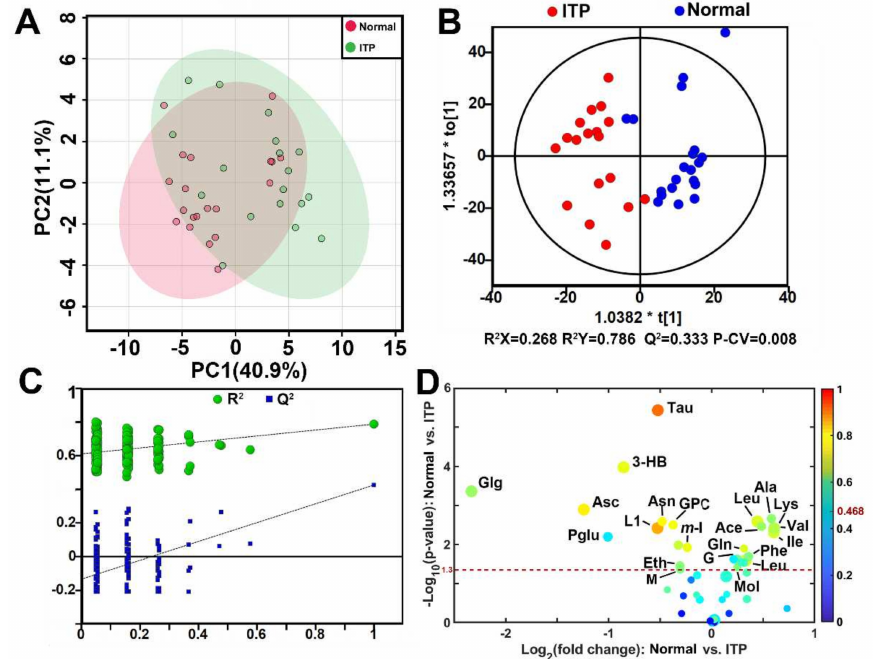
Figure 2. ( A ). The scores plot of principal component analysis (PCA) of 1 H NMR spectral data of spleen derived from the ITP patients and the normal subjects. ( B ). The scores plot of orthogonal partial least squares − discriminant analysis (OPLS − DA) of 1 H NMR spectral data. P − CV: p -value of CV − ANOVA analysis. ( C ). The plot of response permutation test of OPLS − DA model. ( D ). The vol- cano plots of discriminative metabolites between the ITP and the normal subjects. Each dot represents a metabolite. The color of dots represents the absolute value of Pcorr and the size of dot represents the VIP. The dash line represents the cut − off value for p -value of the discriminatory metabolites: 3 − HB: 3 − hydroxybutyric acid, Ace: acetate, Ala: alanine, Asc: ascobate, Asn: asparagine, Eth: ethanol; Gln: